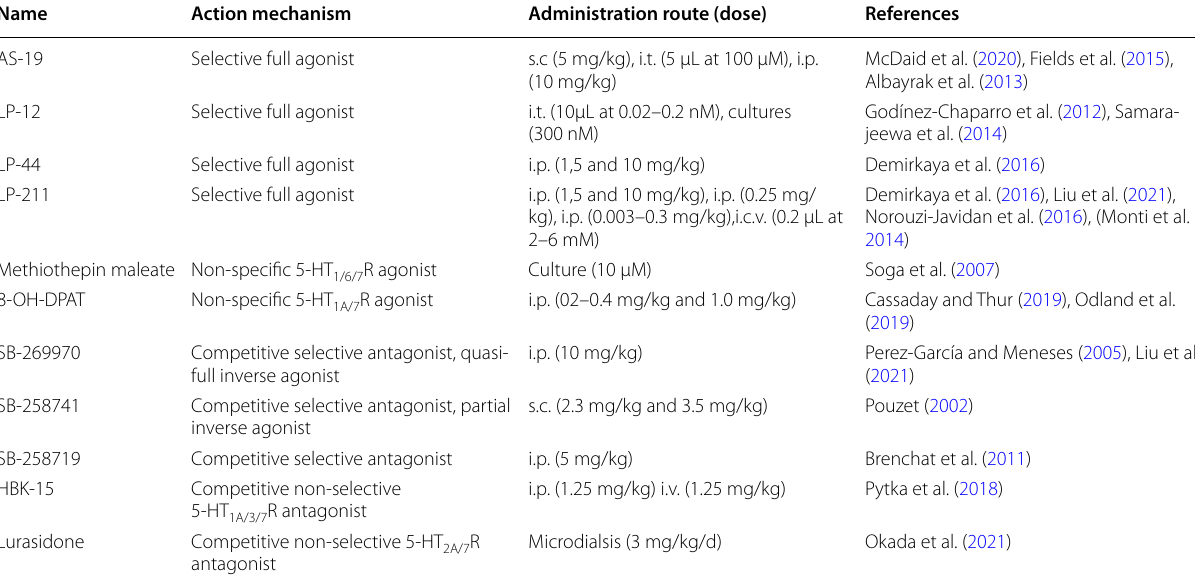
R used in preclinical 7